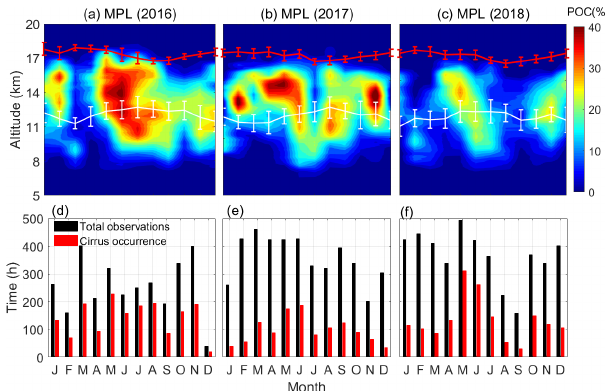
Figure 8. Monthly variation in the POC as a function of altitude during (a) 2016, (b) 2017, and (c) 2018. The monthly mean CPT altitude (red line) and COT altitude (white line) with their standard deviations. (d–f) Total hours of lidar operation (black bars) and the available cirrus observations (red bars) for the corresponding